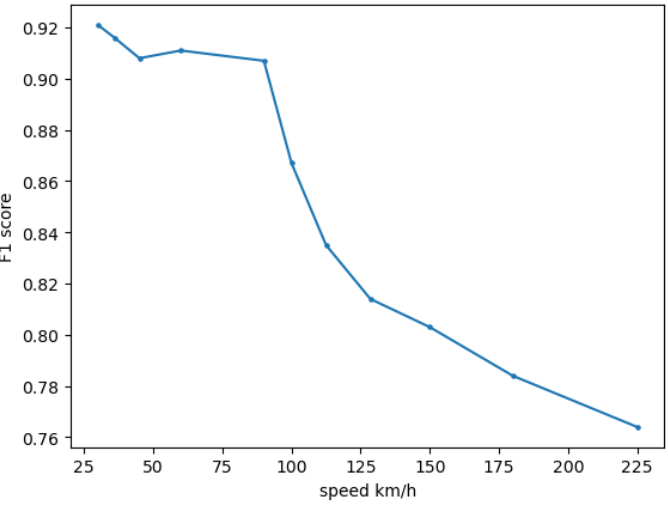
Figure 7. F1 score of the tracking model at various emulated